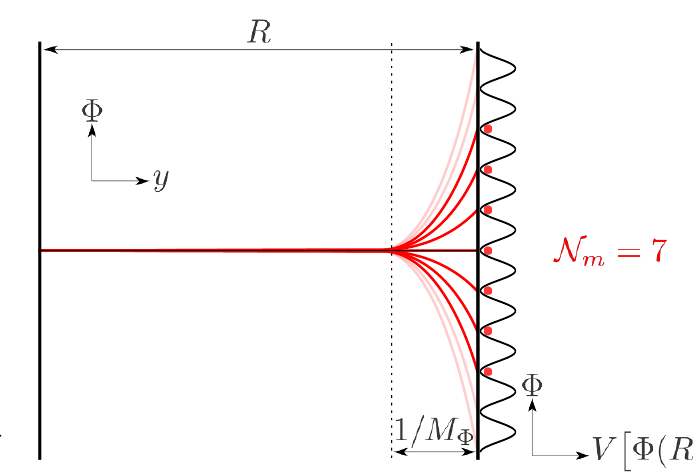
Figure 16 . Diagram of possible metastable (cid:12)eld pro(cid:12)les (cid:8)( y ) outlined in red, and associated boundary values (cid:8)( R ) indicated by red dots. Due to the (cid:12)nite maximum derivative of the brane potential V [(cid:8)( R )], the potentials can only accommodate The stress-energy of the (cid:12)eld pro(cid:12)le is localized in a small range of width branes, and at low energies manifests itself as a brane